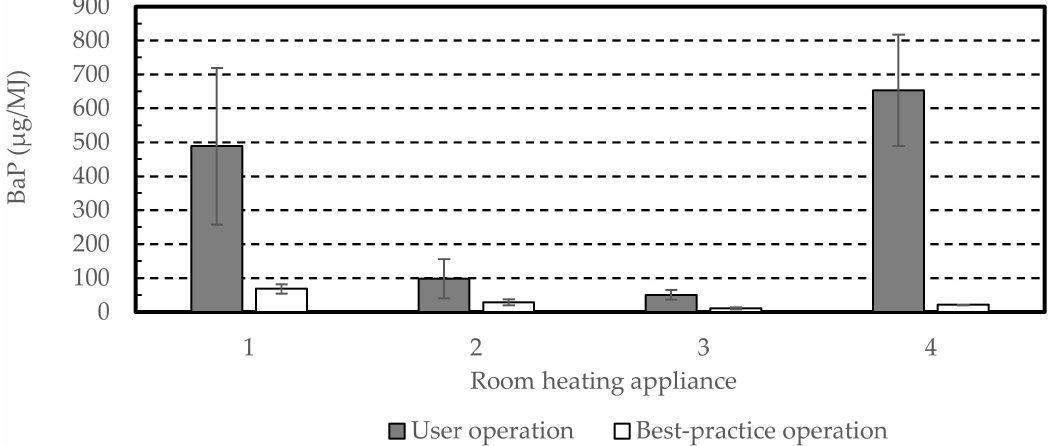
Figure 3. Average benzo(a)pyrene emissions of three batches of four room-heating appliances (1, 2, 4: chimney stoves, 3: tiled stove) when operated according to users’ own habits and according to best-practice heating operation. Error bars represent the standard deviation of measurements. Own figure, based on data of